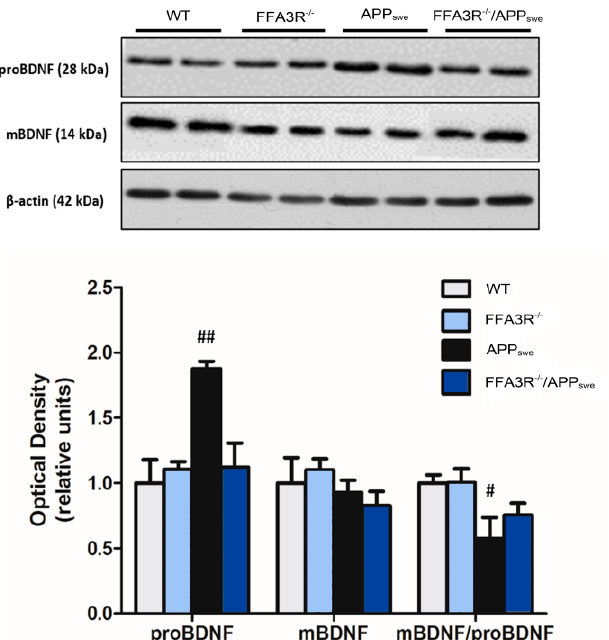
Figure 7. BDNF maturation is impaired in APP swe mice and restored in FFA3R − / − /APP swe mice. Levels of proBDNF and mBDNF were analyzed in total hippocampal extracts of WT, FFA3R − / − , APP swe , and FFA3R − / − /APP swe mice by Western blot. We show a representative blot and the quantification of immunoreactive bands for each protein normalized to that of the corresponding β -actin internal control values. Results are expressed as mean ± SEM (n = 6) normalized to the ratio of WT mice. # p < 0.05, ## p < 0.01 vs. WT.